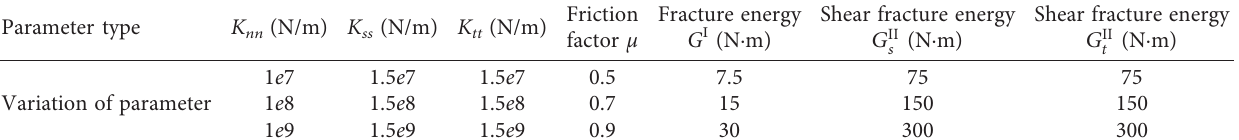
Table 3: Variation of values for modeling parameters.